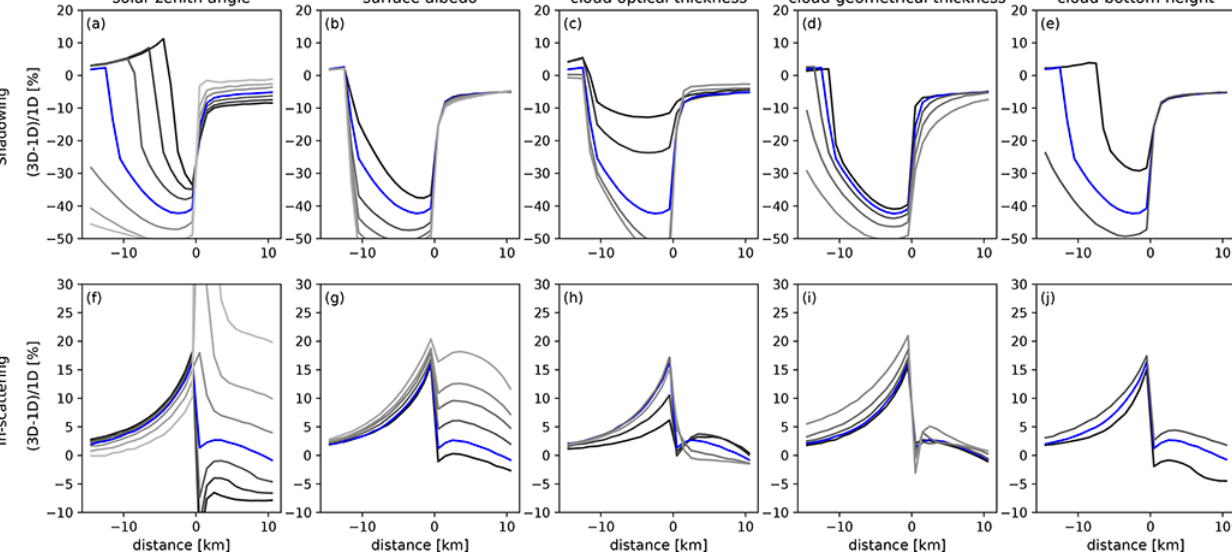
panels show 1D simulations for a clear atmosphere ( − 15 < x < 0 km) and for the same atmosphere with 1D cloud layer included (0 < x < 10 km). The upper panels (a)–(c) are for the liquid water cloud at 2–3 km altitude and the lower panels (d)–(f) for the ice water cloud at 9–10 km altitude. The layer- AMF in clear sky at high altitudes is approximately 2.5, cor-